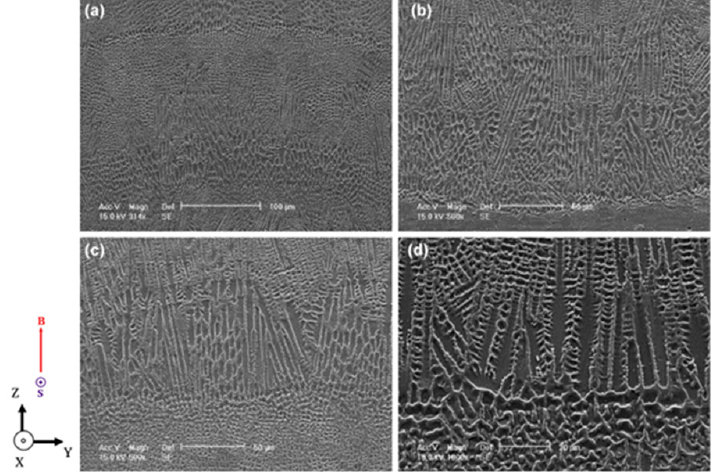
Figure 6. Transverse (X-Z) section of DLD AM IN625 (adapted with permission from [34] 2009, Elsevier).